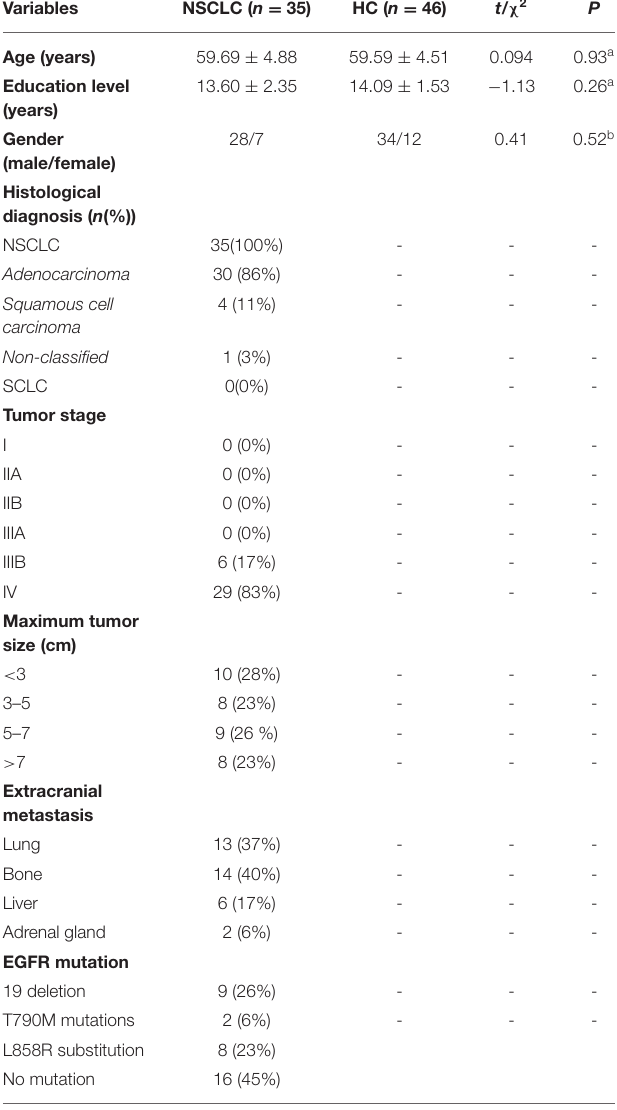
TABLE 1 | Demographic and clinical characteristics of